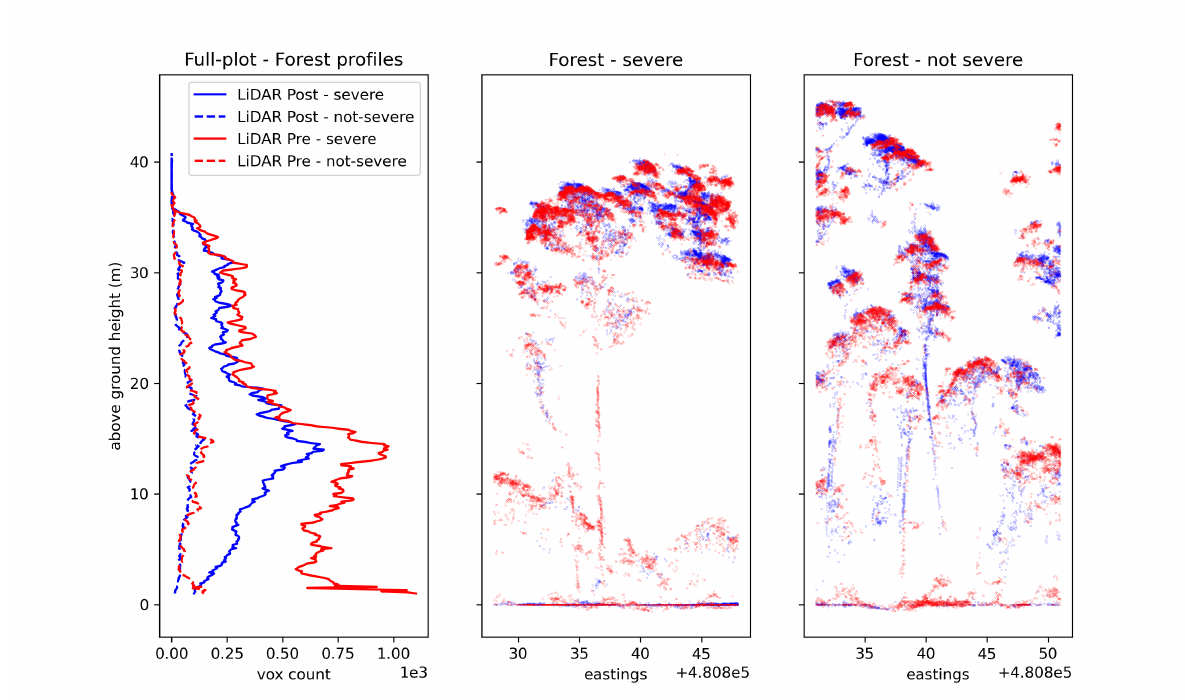
Figure 4. Differences in UAS LiDAR point cloud information pre- and post-fire within areas classified as forest.